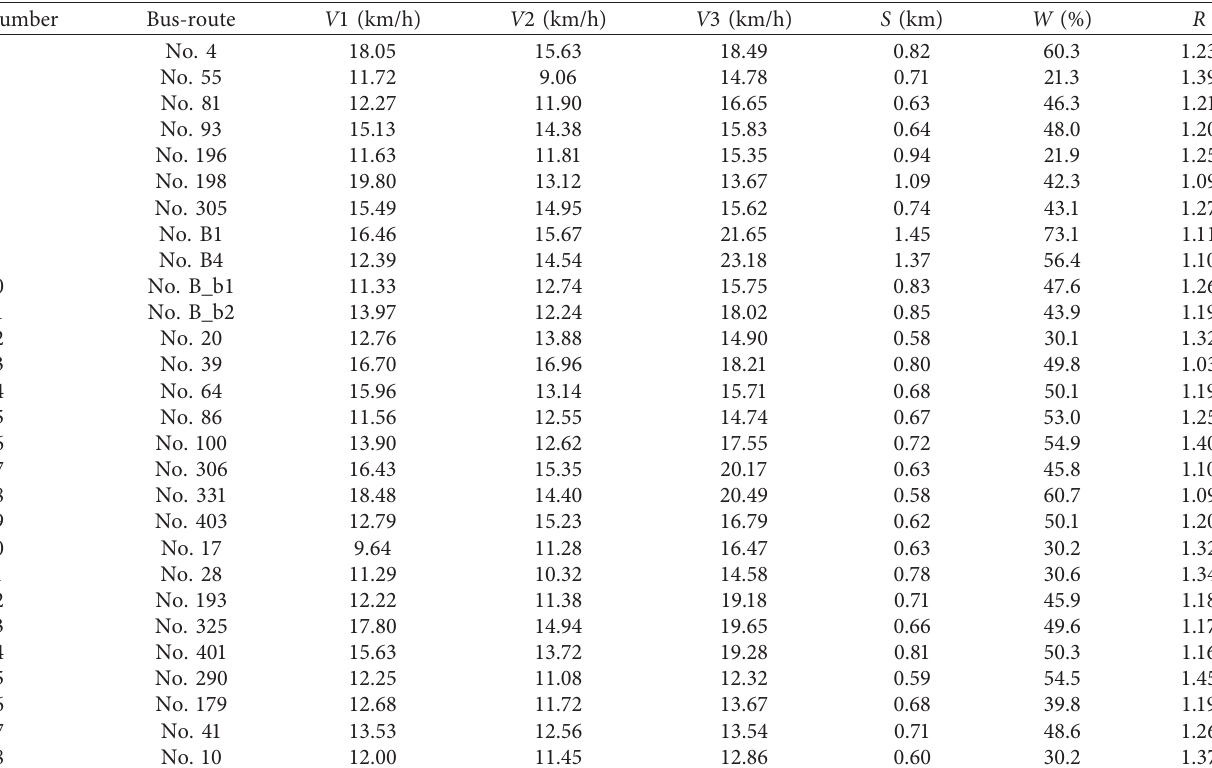
Table 2: Evaluation index value of bus-line speed